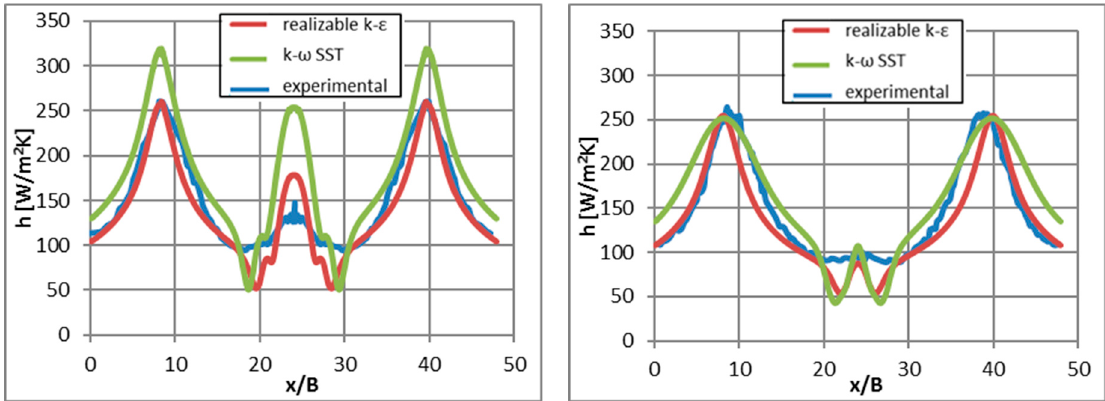
Figure 18. Comparison between numerical and experimental data of the convective heat transfer coefficients for the multi slot configurations with H/B = 16 and Re = 5500: 3 slots ( left ) and 2 slots ( right ). Table 6. Average heat transfer coefficient and percentage errors of the CFD models with respect to experimental values of the multi slot jet configurations for H/B = 16.